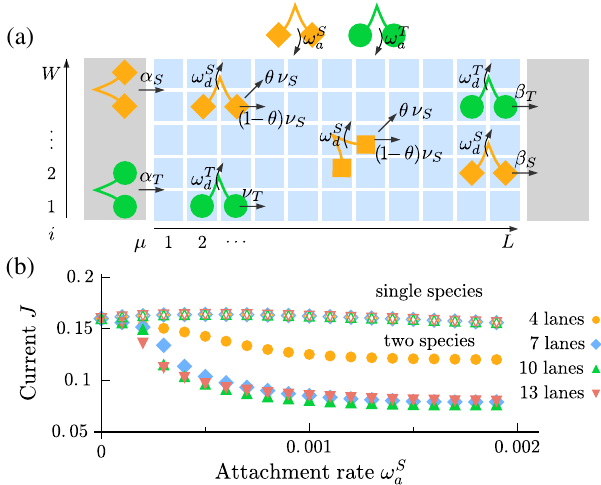
FIG. 10. Illustrationofthe extendedmodelandcurrentreduction for different numbers of lanes. (a) Dimers populate a lattice of width W and length L . Periodic boundary conditions are employed along the transversal direction. Dimers of species T move their rear legsto the neighboring lattice site on the right of their front legsat a rate ν T . Dimers of species S move their rear legs to the neighboring lattice site on the right of the front legs at a rate ð 1 − θ Þ ν S and to the neighboring lattice site on the upper-right of the front legs at a rate θν S . All particles exclude each other. Dimers either enter the system at the left boundary at rates α S and α T or randomly attach to the lattice at respective rates ω S a and ω T a . Lane-switching particles may either attach with both legs in the same lane at rate ð 1 − θ Þ ω S a or, alternatively, with feet in neighboring lanes at rate θω S a . Particles exit the system at the right boundary at rates β S and ω S ω T β T or stochastically detach from the lattice at rates d . d and (b) Simulation results show the current for systems with different numbersof lanes W without anyspiraling motion (empty symbols) and with rare stochastic lane switching (filled symbols) of θ ¼ 0 . 1 . If no lane switching is possible, the current is not affected by the number of lanes, and it reduces to the single-species TASEP with Langmuir kinetics and dimeric particles [77 – 79], as identical hopping rates for both species are chosen. However, if the second species is allowed to switch lanes, a rapid current reduction similar to the one described above for the main model can be observed. Note that the current is no longer conserved within the system, such that a spatial average over a lane is taken. Other parameter values include ω S d ¼ ω T d ¼ ω T a ¼ 0 . 001 , ν S ¼ ν T ¼ 1 , α ¼ 0